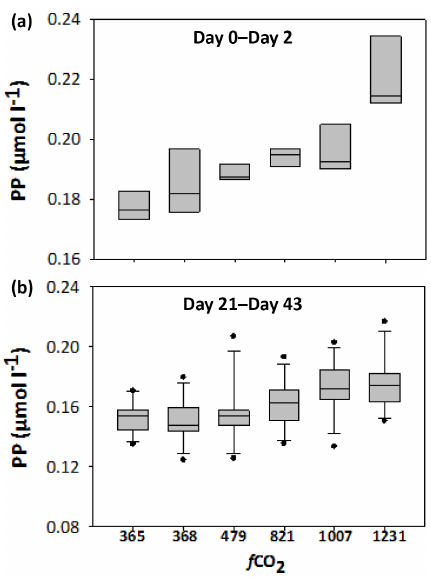
Figure 7. PP concentration in the mesocosms during the initial phase from day 0 to day 2 (a) and from day 23 until the end (b) of